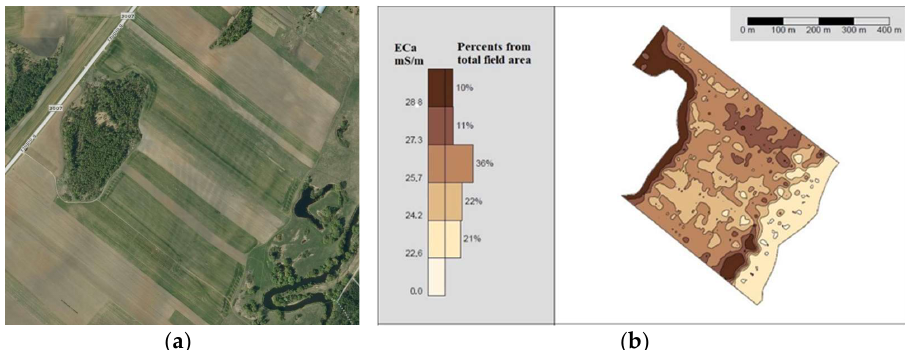
Figure 1. Map of the experimental field (55°40’27.7” N 24°08’43.9” E): ( a ) original view; ( b ) soil’s electrical conductivity.